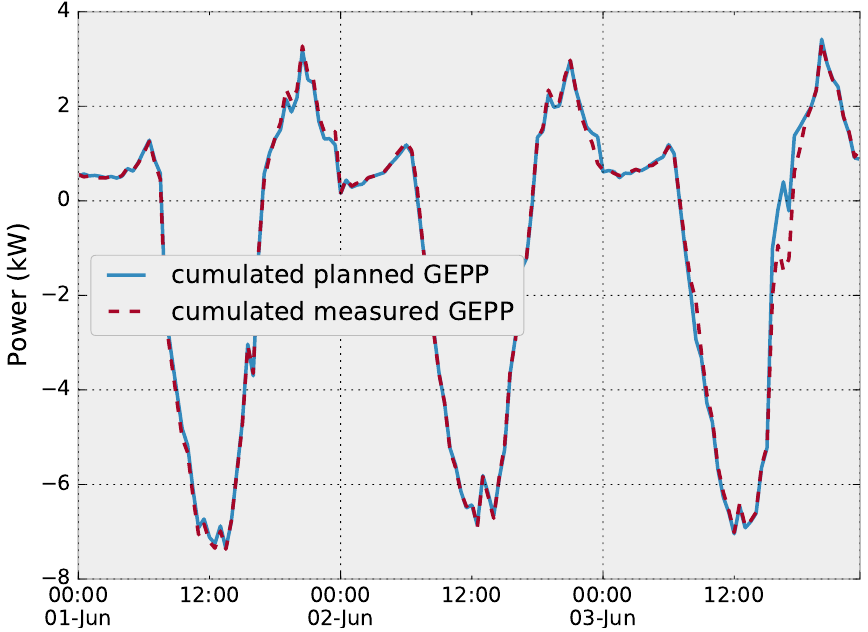
Figure 6. Aggregated user-committed GEPP vs. actual cumulative